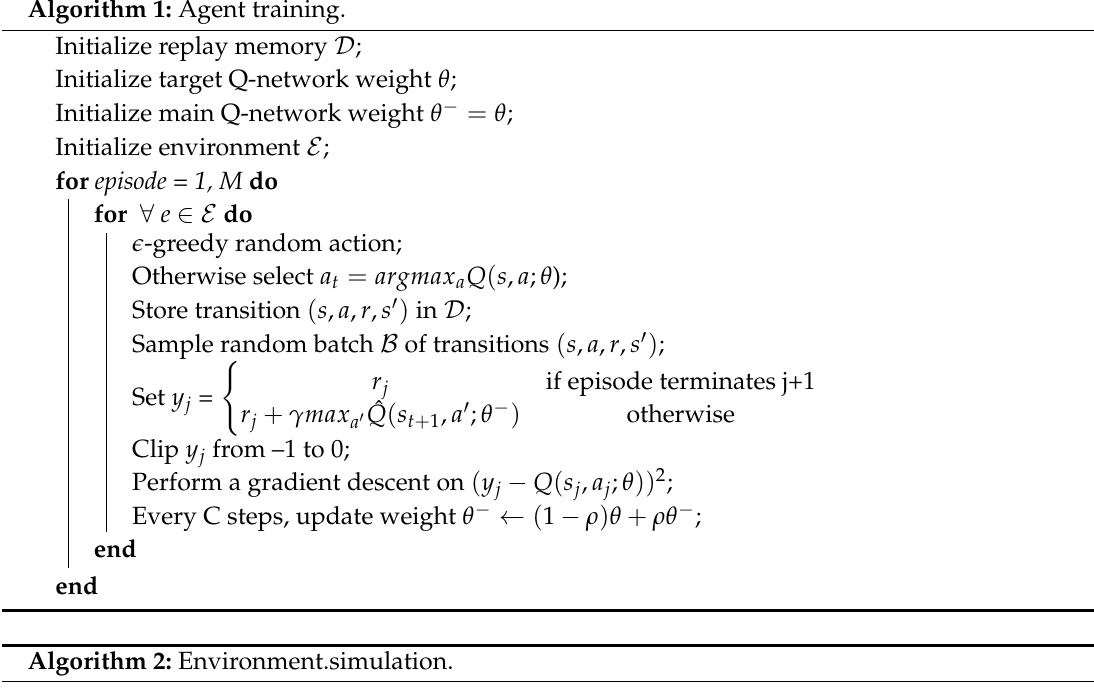
Algorithm 1: Agent training.